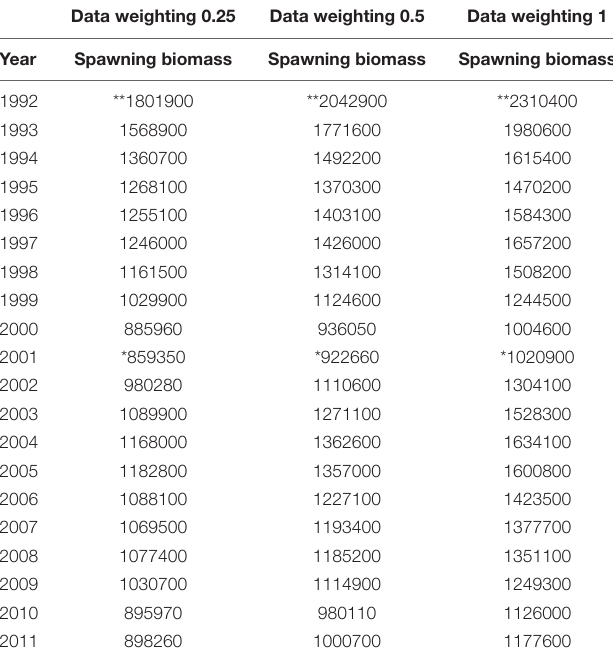
TABLE 3 | Spawning biomass in three different data weightings. Data weighting 0.25